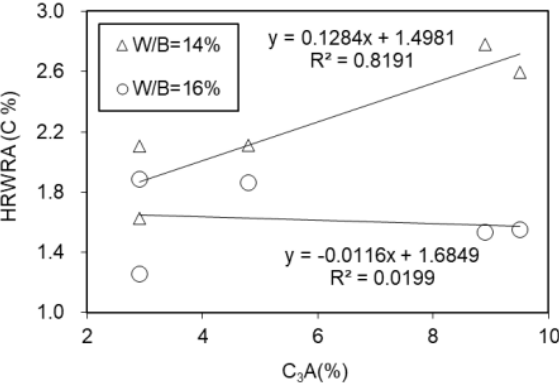
Figure 3. Relations between C 3 A content and HRWRA addition ratio.